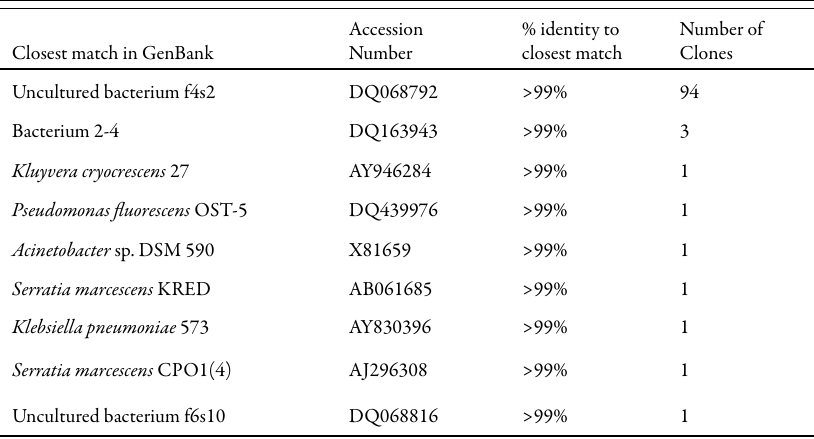
table 2. NcBI BLAst results for the 16s rrNA gene from 104 clones from the field-fresh colony collected from